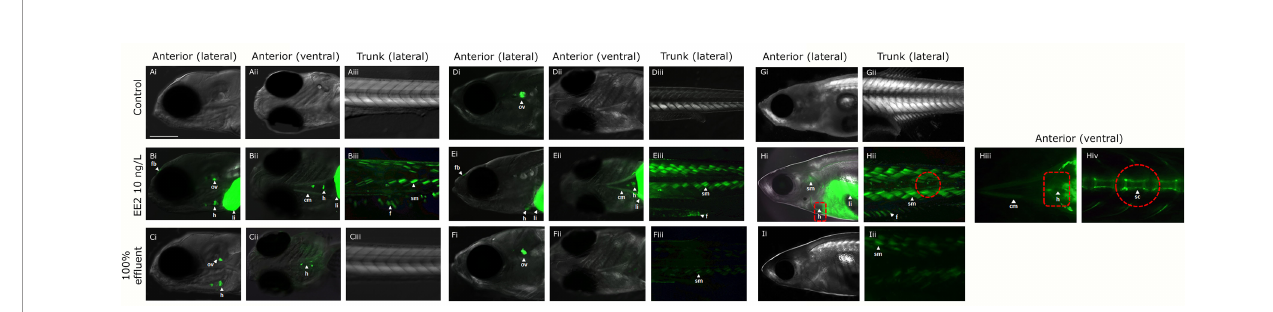
FIGURE 4 | Expression of GFP in body tissues in ERE-GFP Casper zebra fi sh exposed to EE2 and undiluted WwTW ef fl uent from 0-90 dpf. Transgenic zebra fi sh at 4 dpf in dilution water control (A) , EE2 (10 ng/L, positive control, B ), and wastewater ef fl uent (100%) exposed groups (C) ; at 21 dpf in system water control, D ), EE2 (10 ng/L, E ) and 100% wastewater ef fl uent (F) ; at 30 dpf in system water control (G) , EE2 (10 ng/L, H ) and 100% wastewater ef fl uent (I) . GFP expression is shown for regions in the head (lateral – i and ventral – ii views) and trunk (lateral view - iii). GFP induction was observed in the cranial muscles (cm), fi n (f), forebrain (fb), heart (h), liver (li), otic vesicle (ov), skeletal bone (sc) and somite muscles (sm) in the EE2 exposed fi sh (B, E, H) , and heart, liver and otic vesicle in wastewater ef fl uent exposed fi sh (C, F, I) . Bar = 100 m